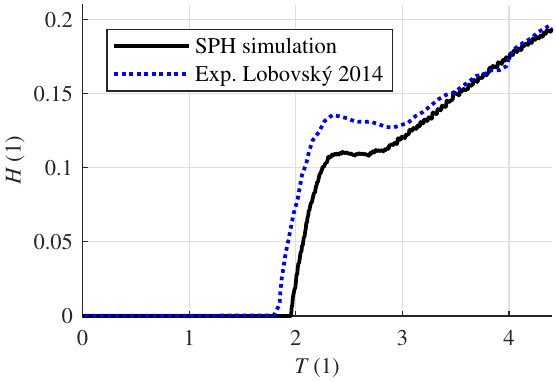
Fig. 5. Non-dimensional surge front position as a function of non-dimensional time. Exp. Martin 1952 [1], Exp. Koshizuka